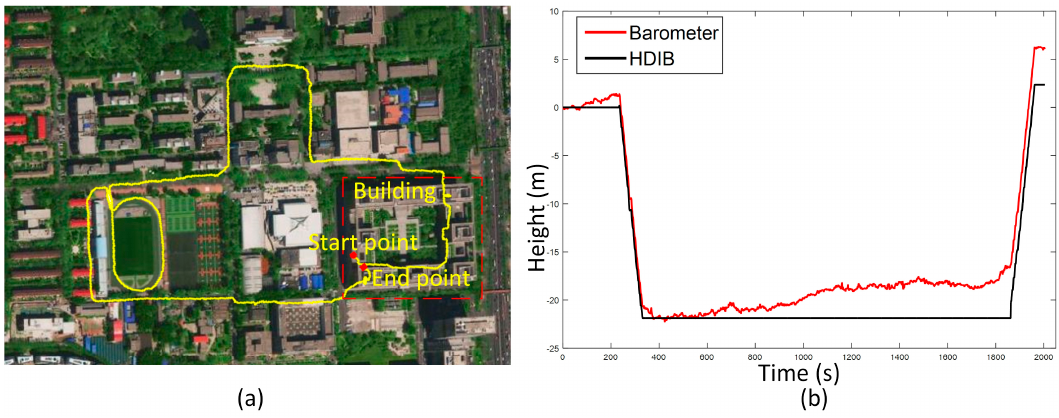
Figure 33. Positioning result of Traj_6 overlaid on a satellite campus picture; ( a ) is the top view; ( b ) is height estimation result. TTDE of this test is 1.04% and the height error is 2.35 m.